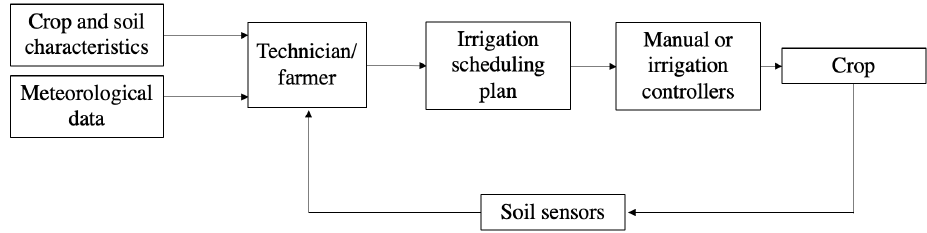
Figure 1. Operation diagram of the traditional irrigation